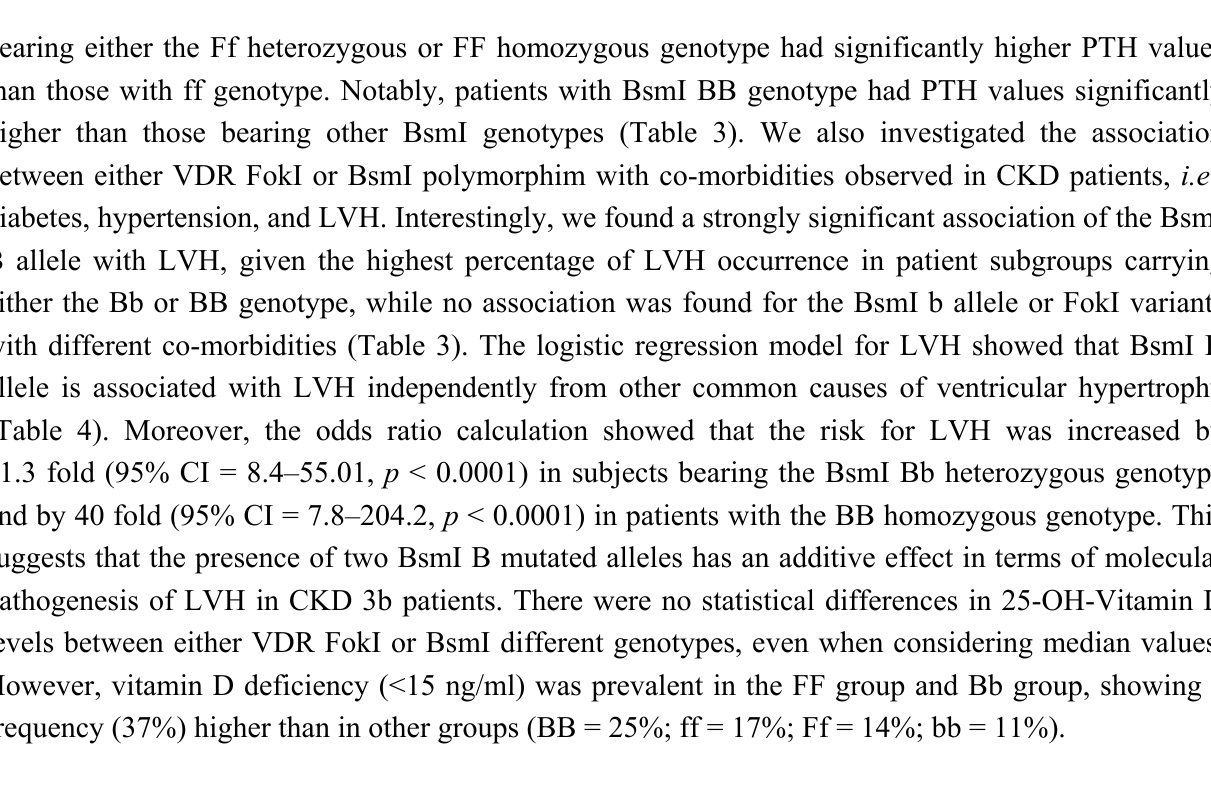
Table 1. Biochemical and Clinical data of the sampled chronic kidney disease (CKD) 3b